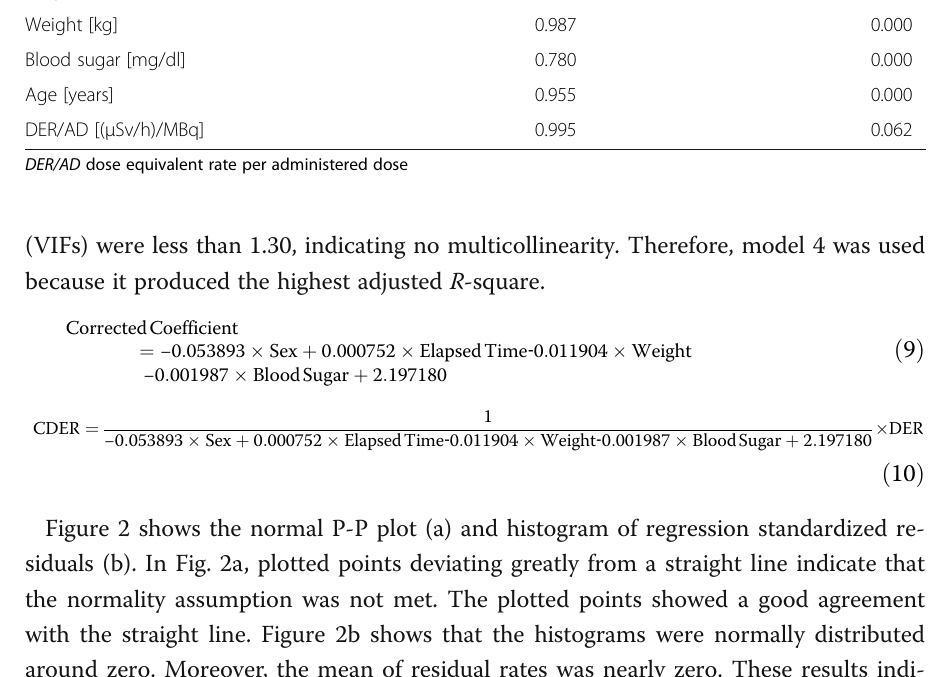
Shapiro-Wilk test W P value 0.980